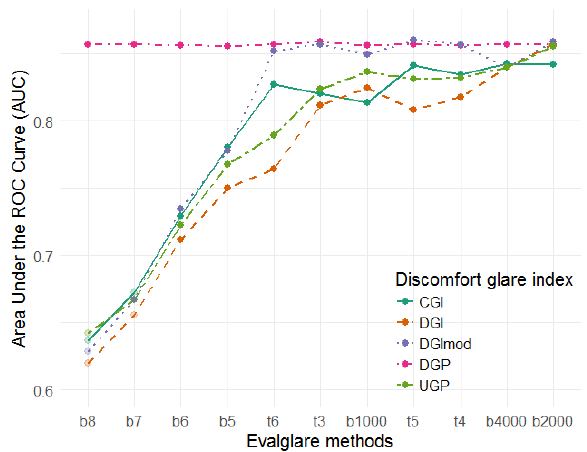
Figure 7. Comparison of AUC for each discomfort glare index between the studied evalglare methods (laboratory study).